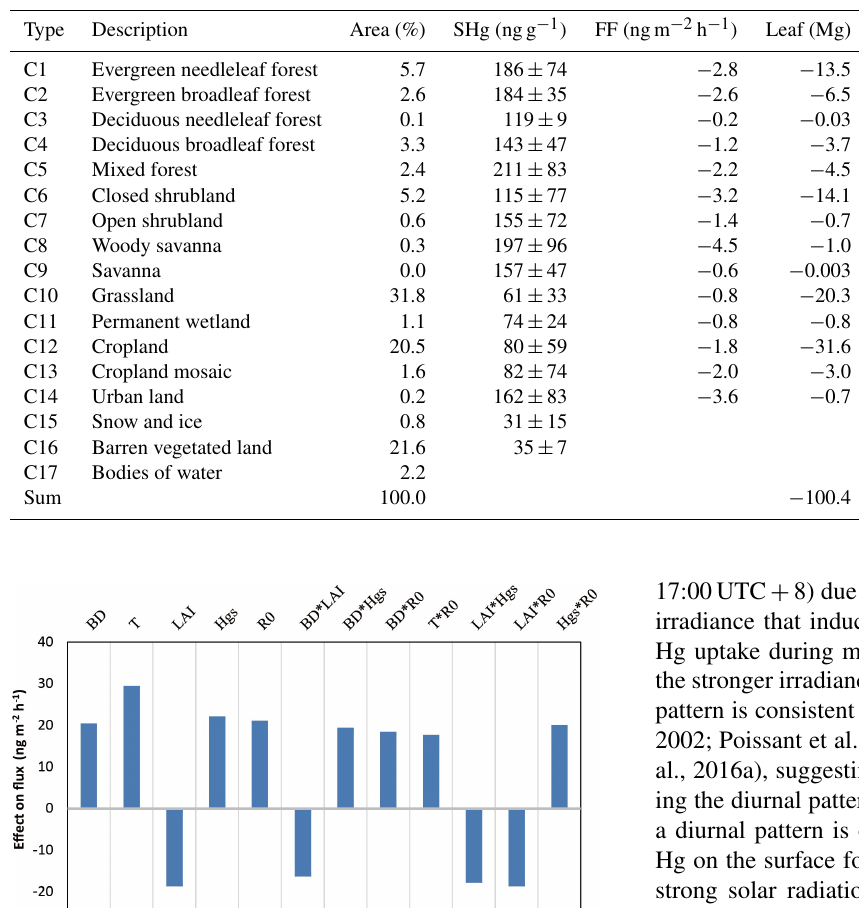
Table 3. Mean annual air–surface fluxes and annual total Hg emissions from individual land use. SHg is the Hg content in surface soil (0–10cm), FF is the Hg 0 flux over foliage, and FS is the Hg 0 flux over soil.